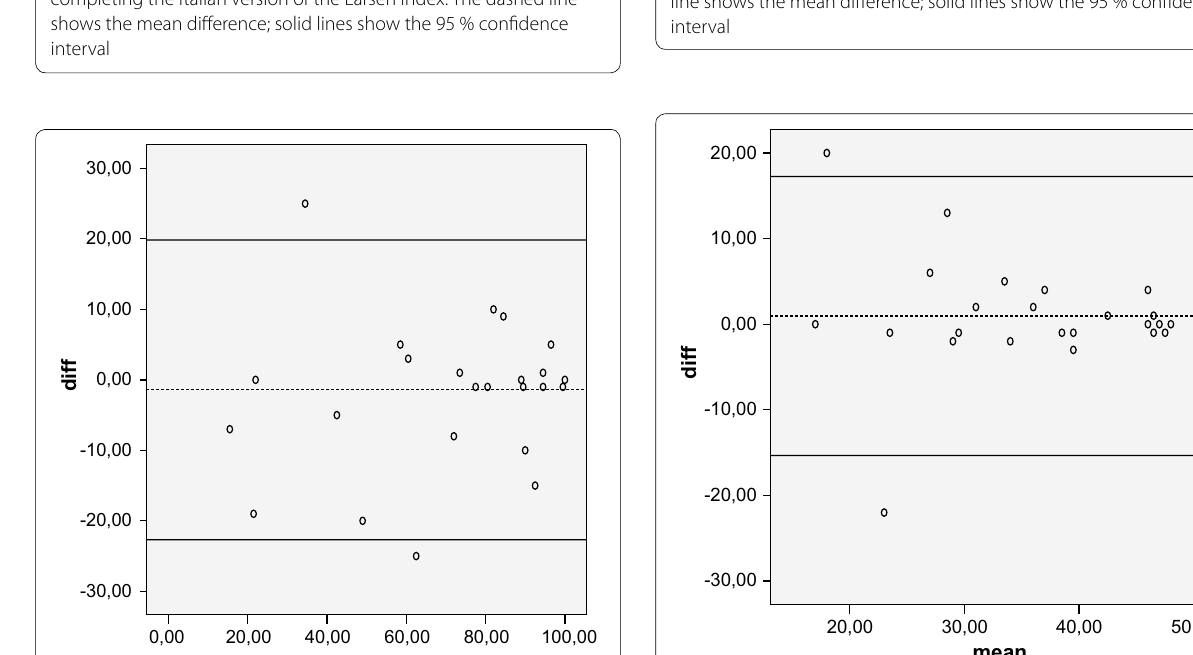
Discriminant ability Ceiling and floor effects, which also have an effect on the responsiveness of a measure, were absent.